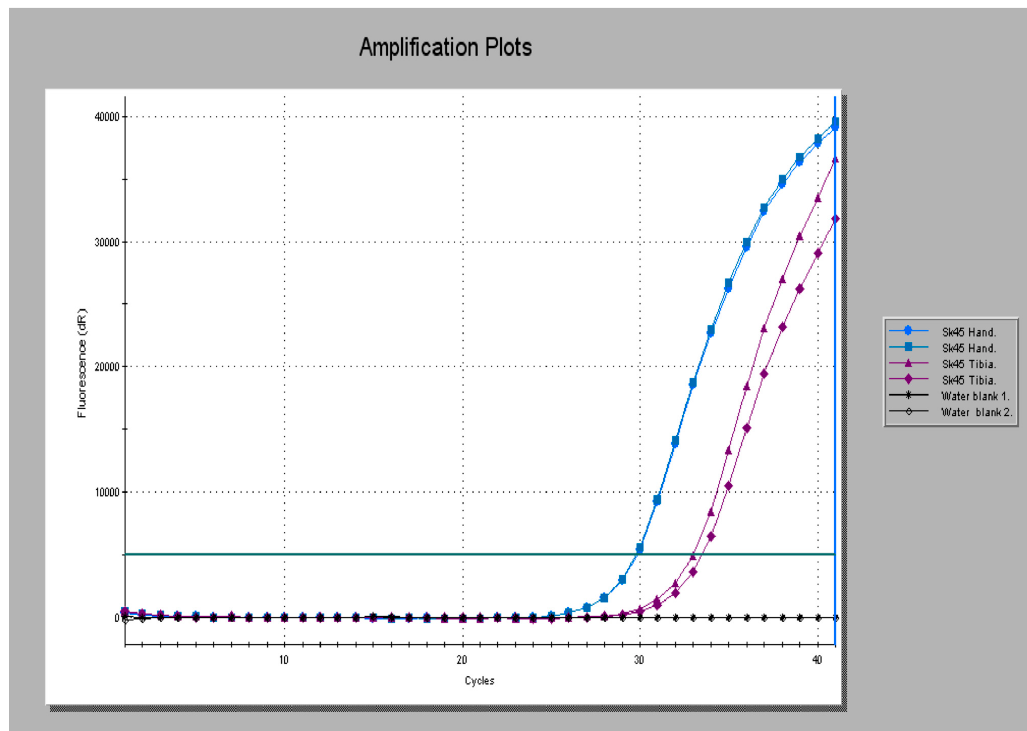
Figure 1. Real Time polymerase chain reaction (PCR) amplification profiles for a medieval period case of lepromatous leprosy (Sk45) obtained using the RLEP PCR method with product reported with a specific probe. Extracts were tested in duplicate. Product is seen amplified from the hand (blue traces) and tibia (red traces). Black traces represent non-template controls (water blanks).